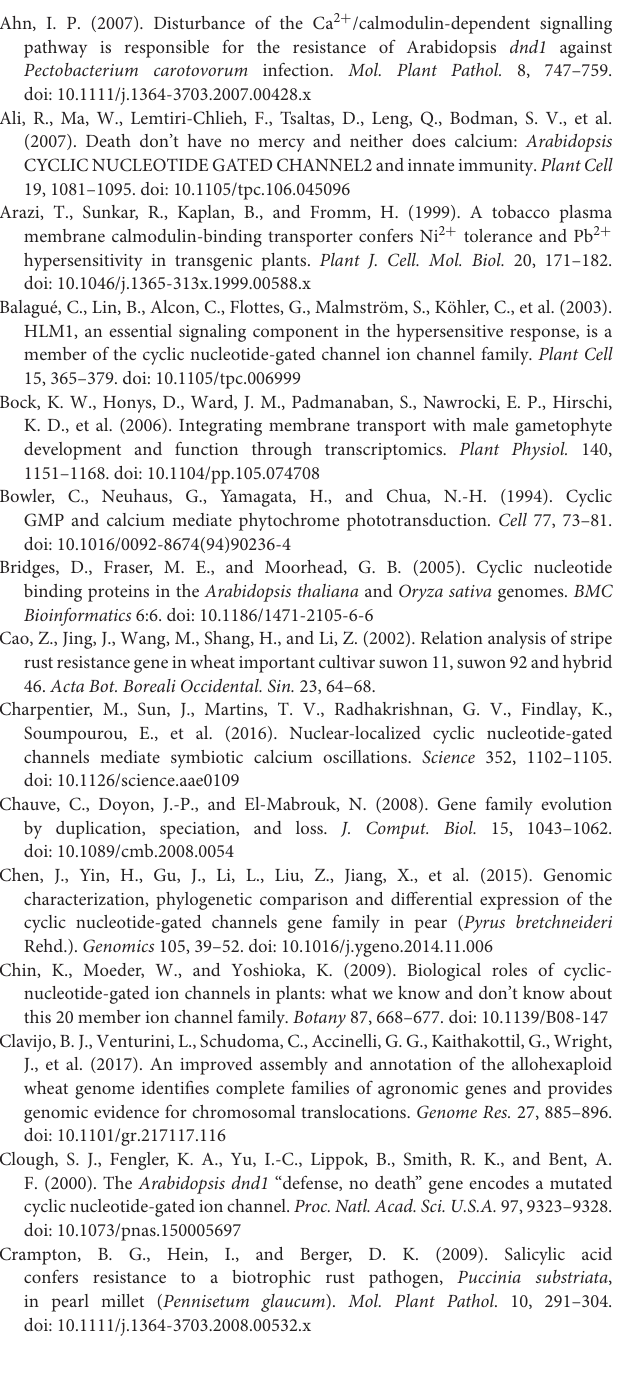
Table S4-2 | COUNTs of all the TaCNGCs in RNA-seq data. Table S5 | Primers used in this